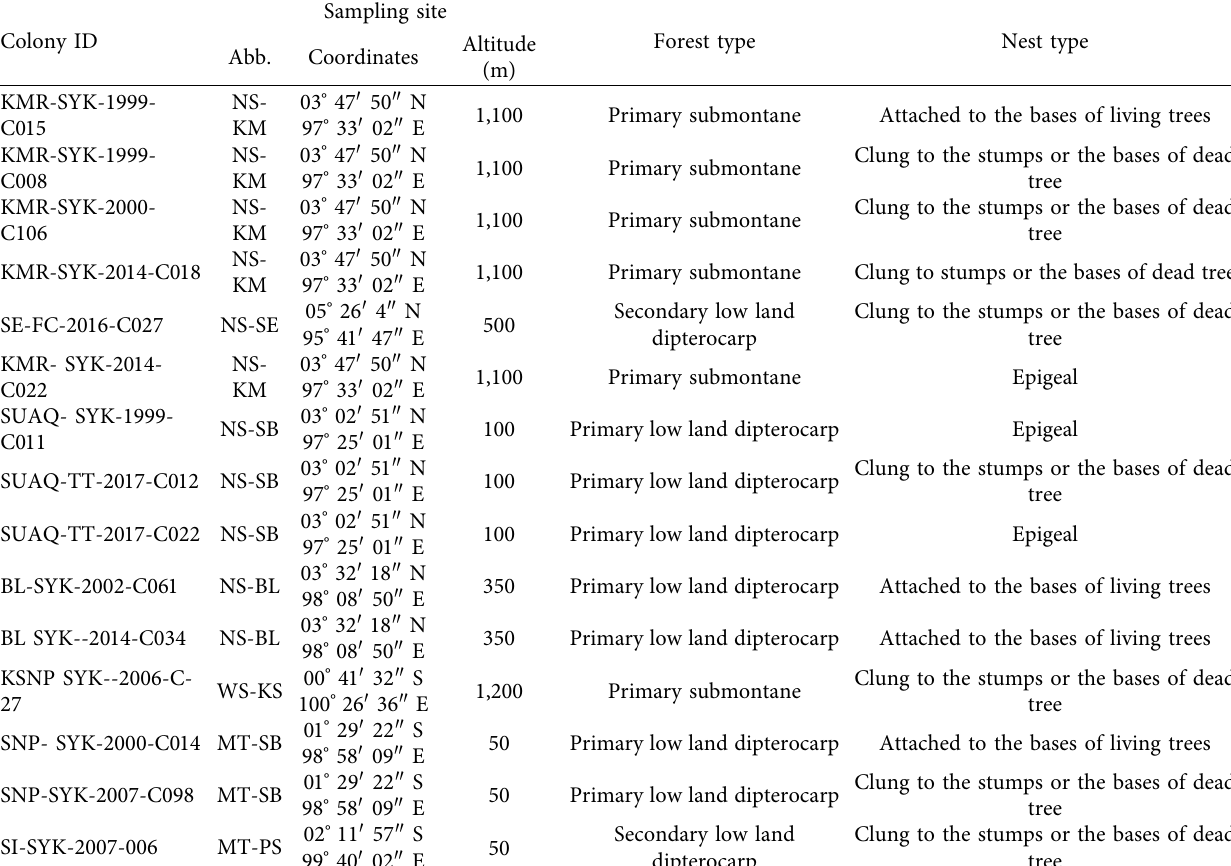
Table 1: Examined colonies of Termes propinquus collected from Sumatra and adjacent islands.